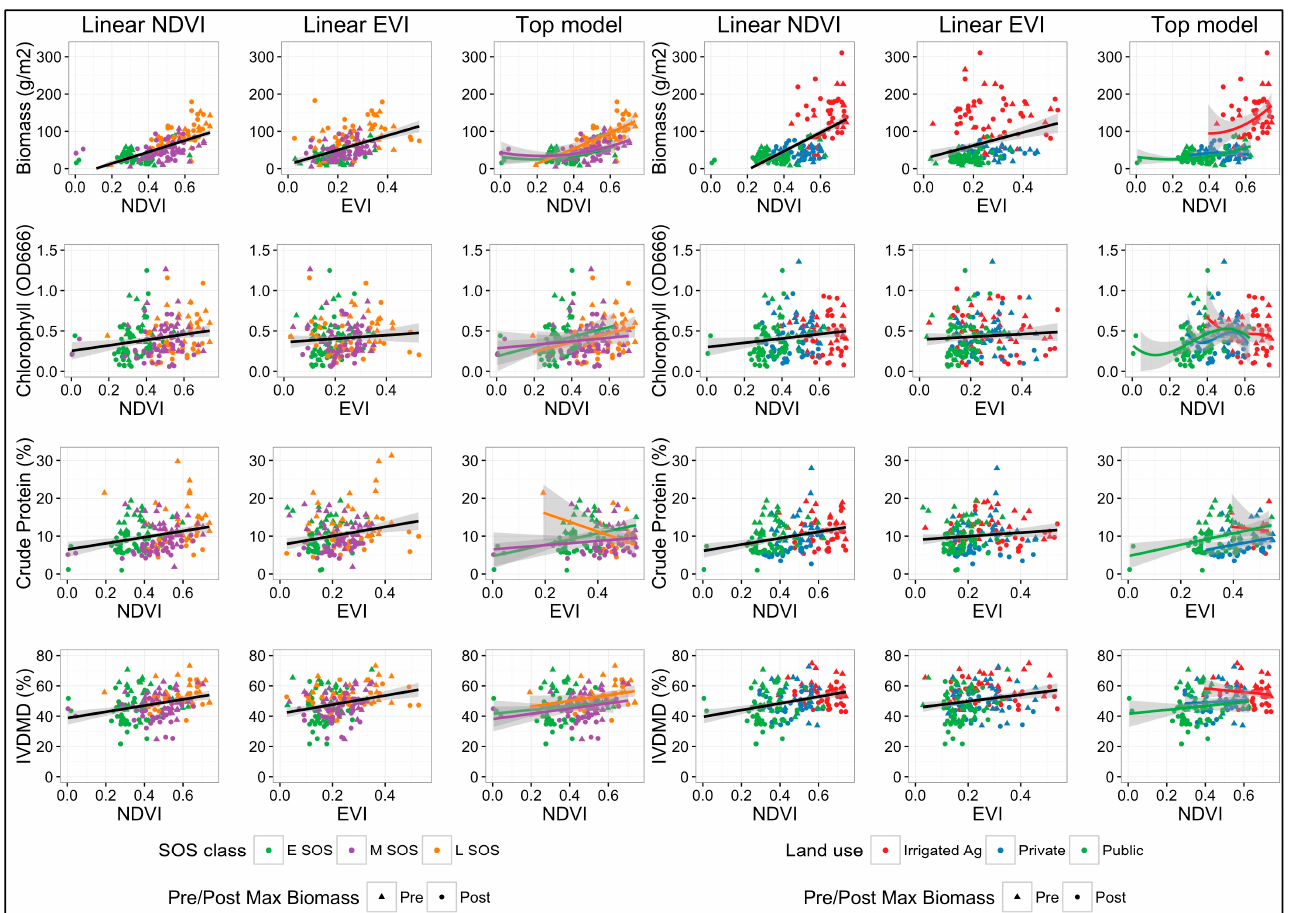
Figure 4. Linear NDVI, linear EVI, and top models of biomass, chlorophyll, crude protein, and IVDMD in grasslands in the different start of season (SOS) and land use classes. Shading represents 95% confidence intervals and shapes represent estimates from before/after the peak in biomass.